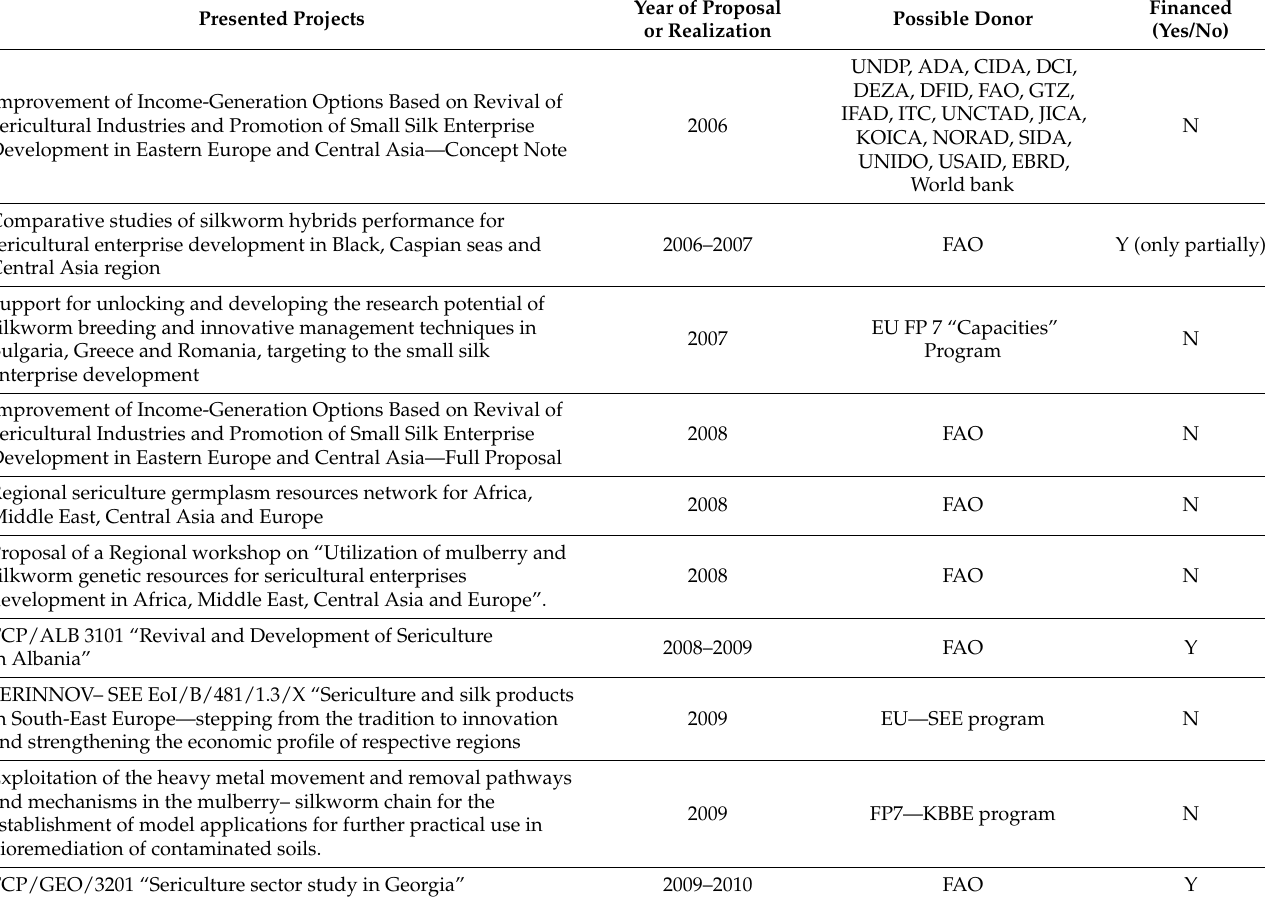
Table 2. BACSA project proposals to different donors